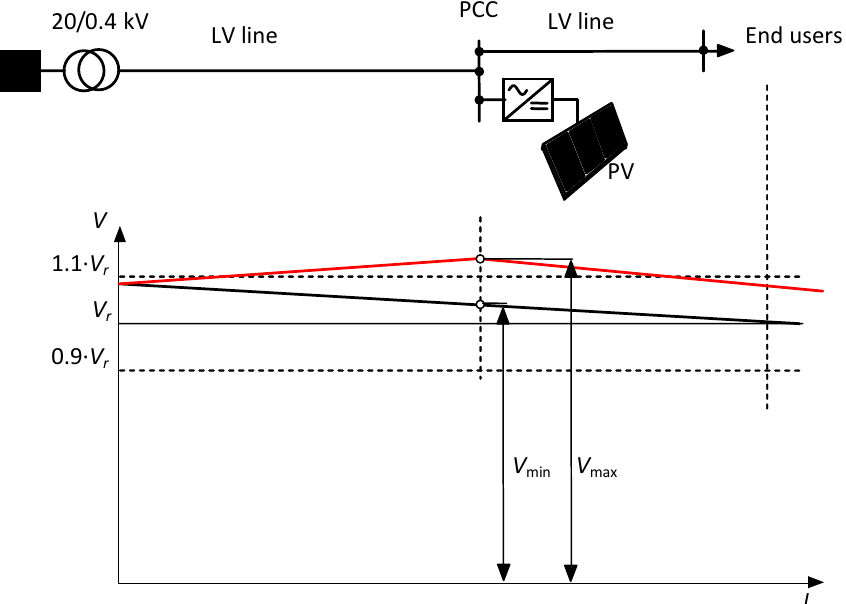
Figure 7. Influence of PV on voltage level: without PV source generating (black line); with PV source generating (red